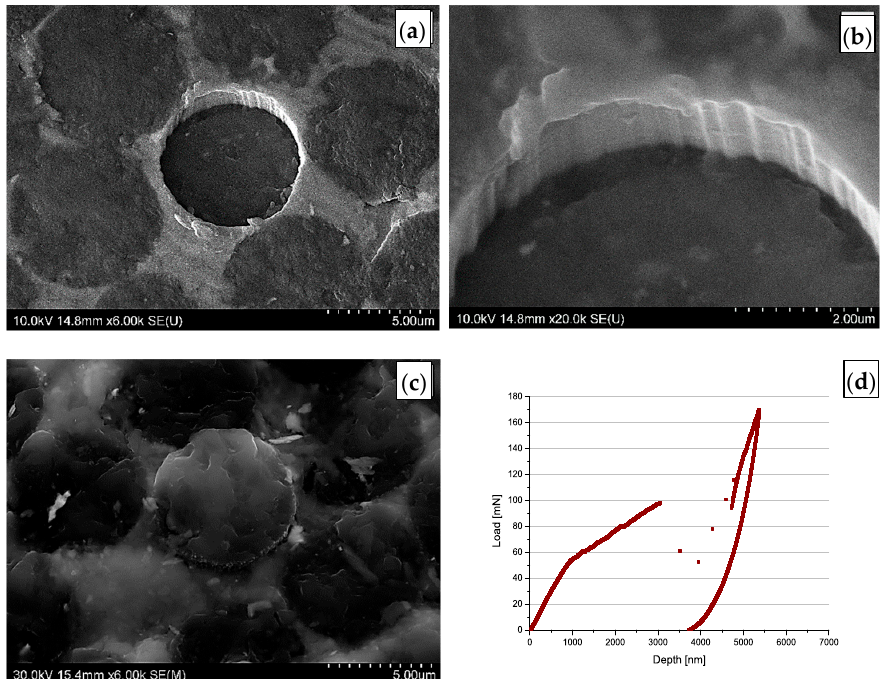
Figure 5. Image of the MMC1 after push-out tests: ( a,b ) top; ( c ) bottom surface of plate; ( d ) typical curve obtained during push out tests with MMC1 sample.